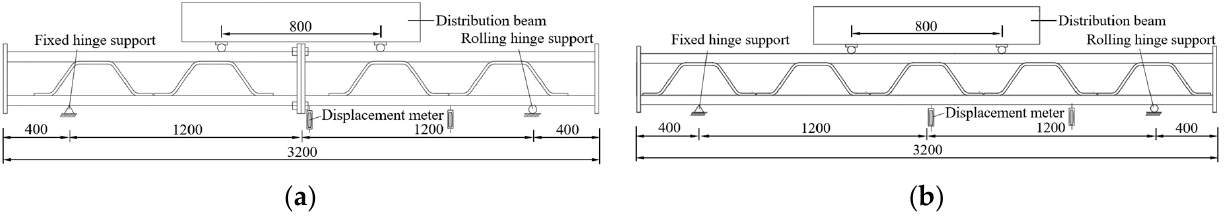
Figure 9. Schematic diagrams of loading test model of SRS components. ( a ) The end-plate joint component and ( b ) the jointless component.